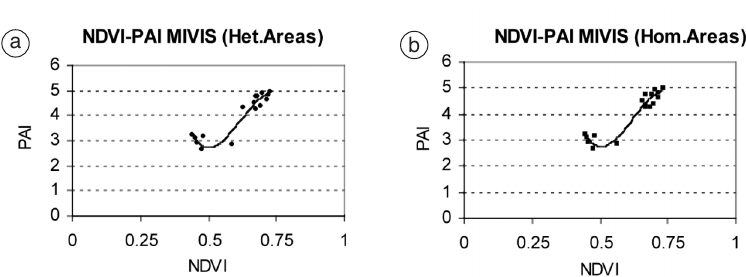
Fig. 6a,b. Cubic polynomial relationships between NDVI values, calculated on the basis of the MIVIS image, and PAI values measured in the field. The coefficient of determination ( R 2 ) is equal to a) 0.91 for the heterogeneous ( y =− 357.39 x 3 + 661.78 x 2 − 394.36 x + 79.122); and b) 0.94 for the homogeneous areas ( y =−3 29.85 x 3 + 615.12 x 2 + − 368.71 x +